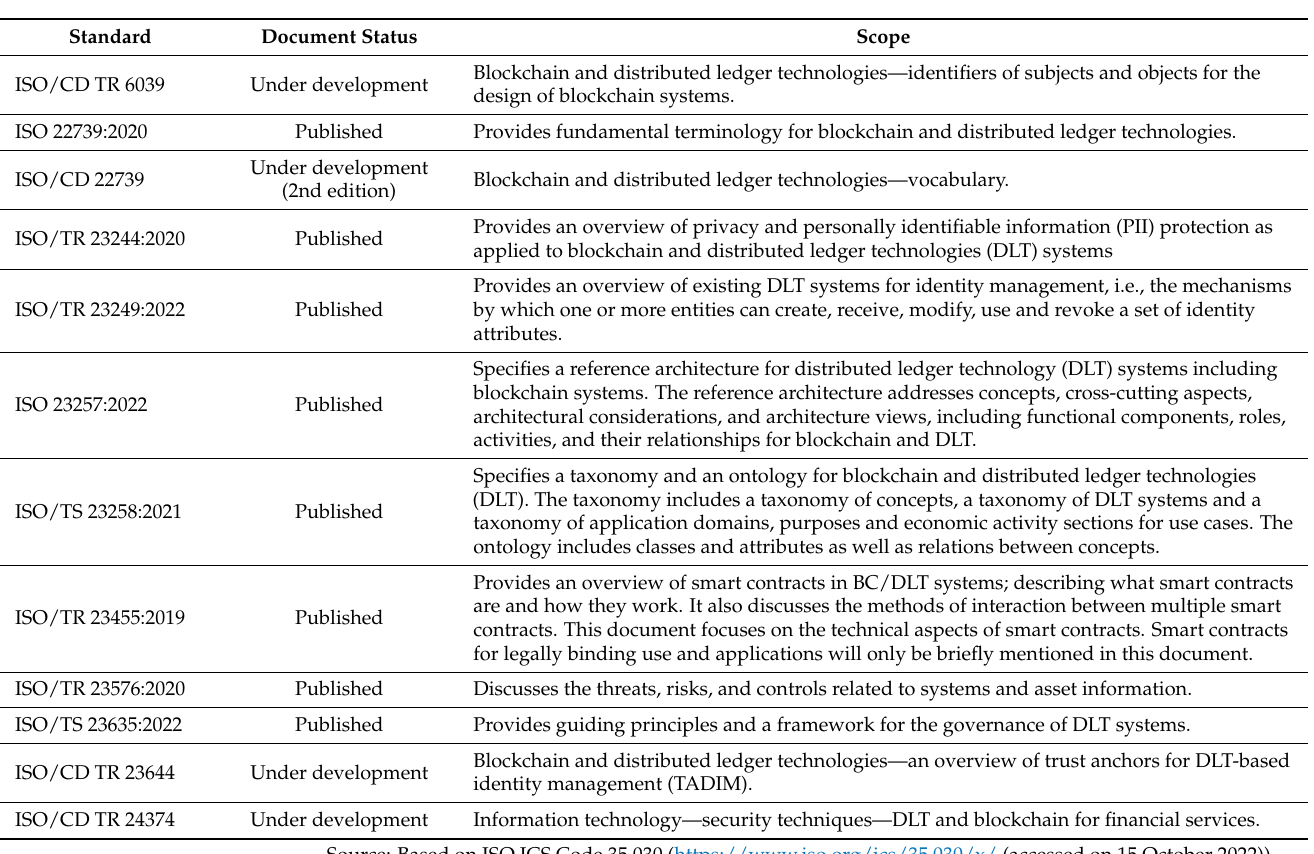
Table 2. Selected International Organization for Standardization blockchain